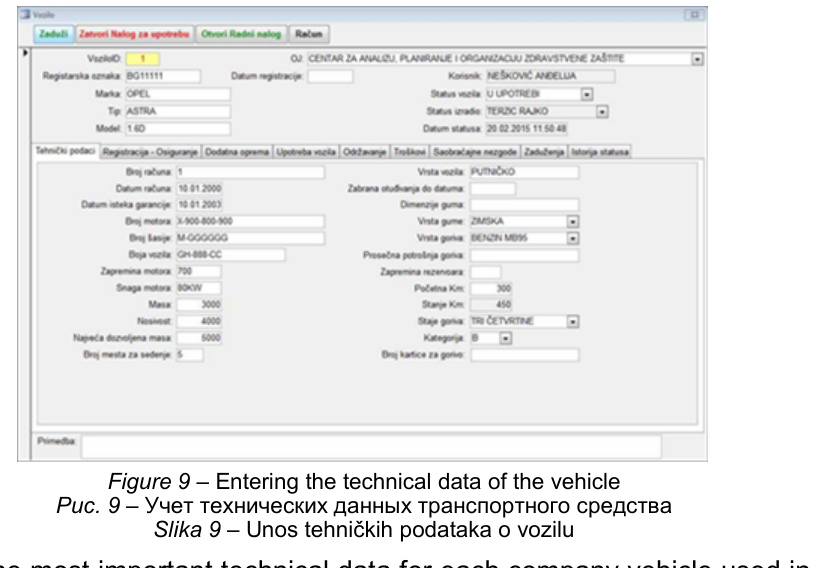
Figure 9 – Entering the technical data of the vehicle Рис . 9 – Учет технических данных транспортного